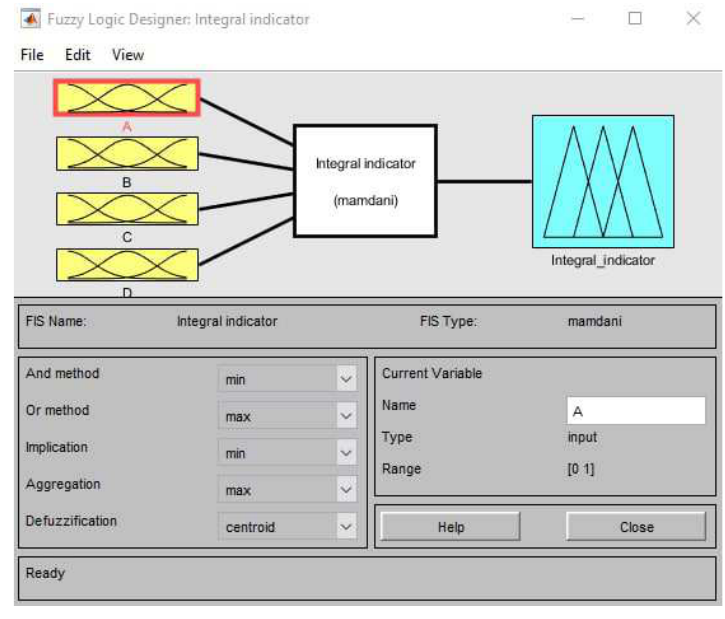
Figure 3. Intermediate parameters (A, B, C,